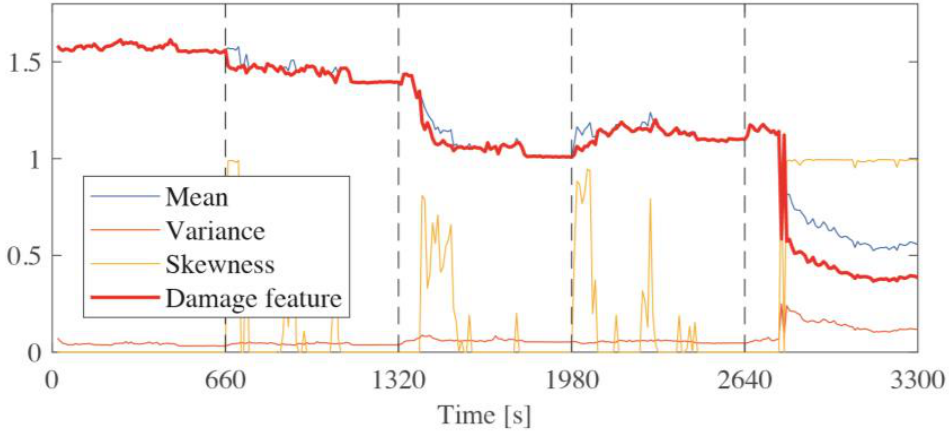
Figure 6. Parameters identified from model fitting.